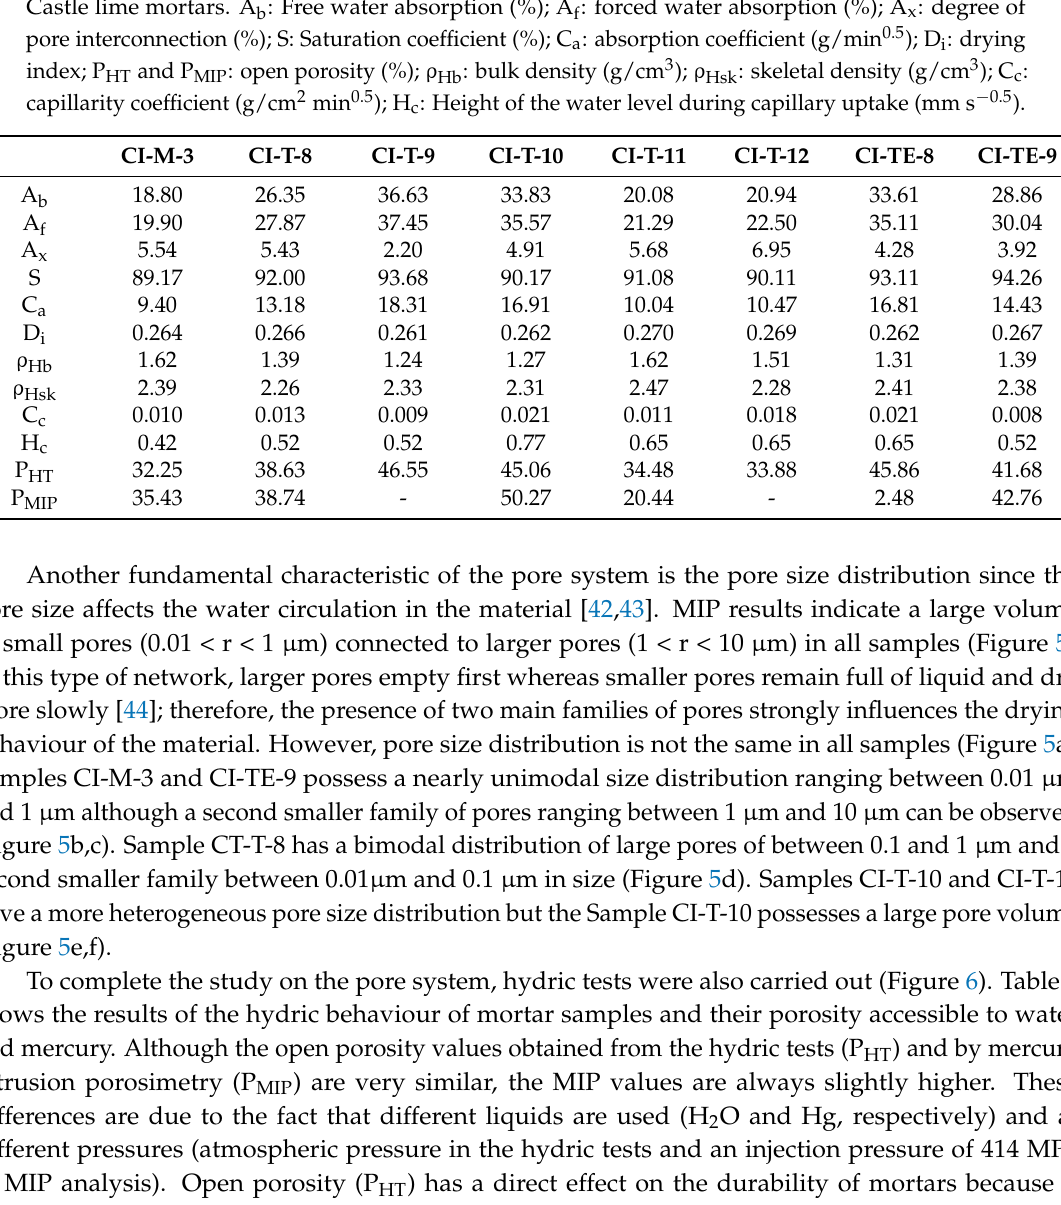
Table 4. Parameters obtained by hydric tests (HT) and mercury intrusion porosimetry (MIP) of